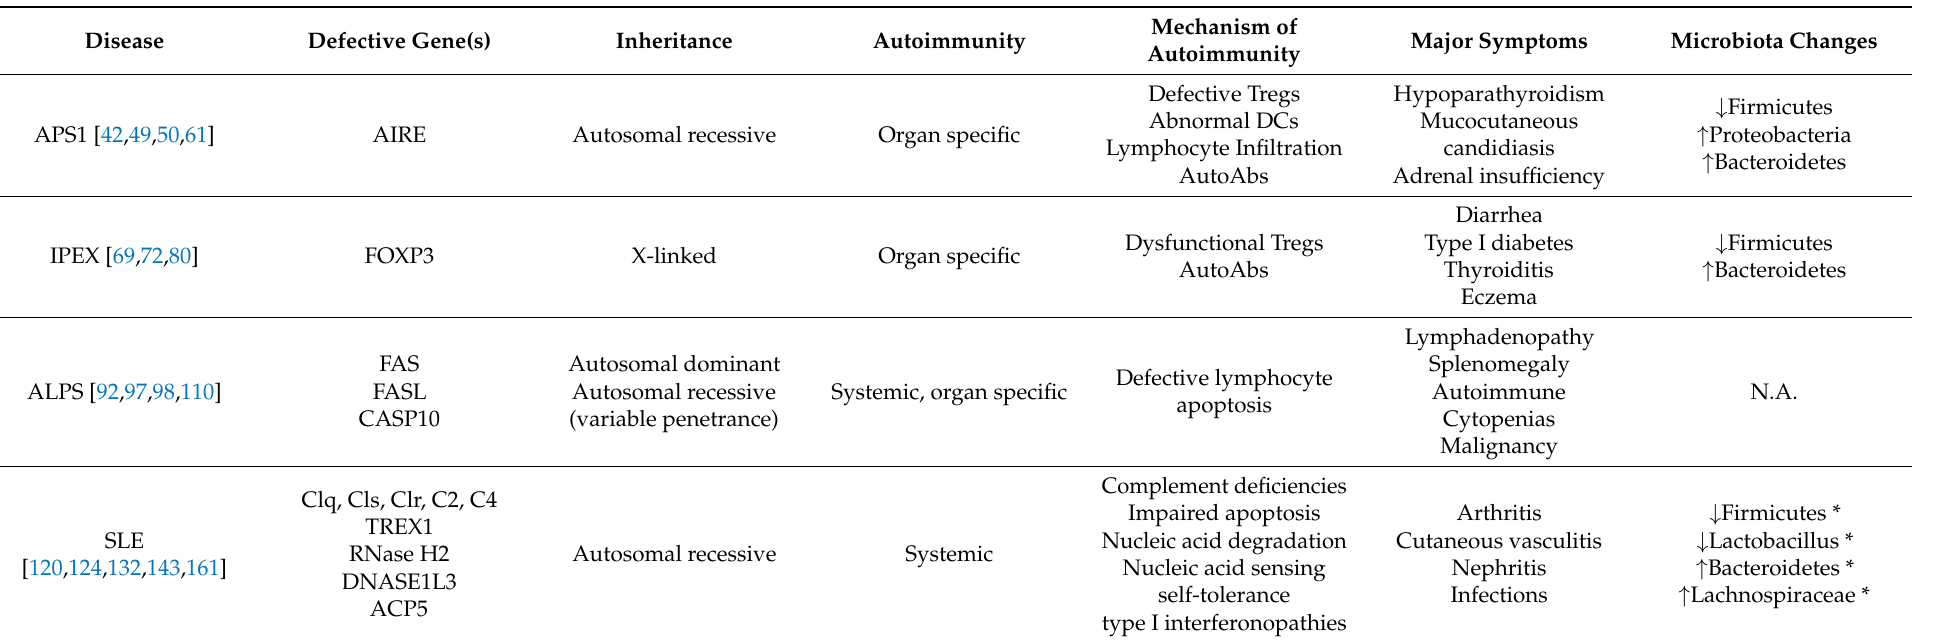
Table 1. Summary of monogenic autoimmune